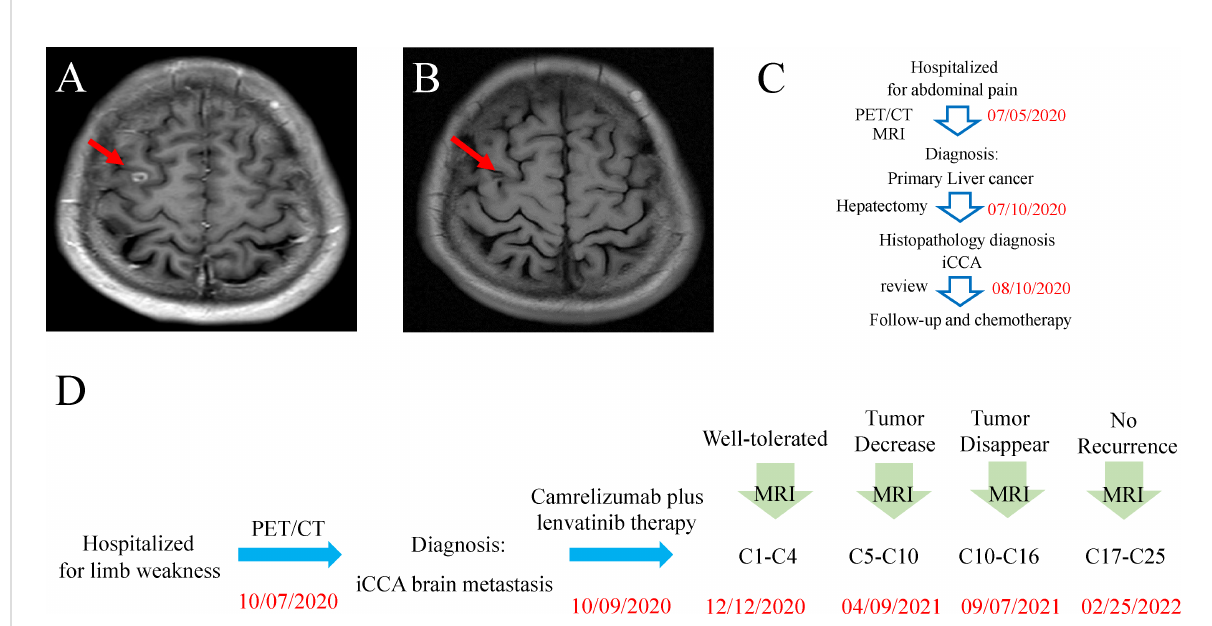
FIGURE 3 (A) Brain MRI scan after treatment with camrelizumab and lenvatinib for 4 cycles. (B) Brain MRI scan after treatment with camrelizumab and lenvatinib for 16 cycles. (C) Timeline of the disease course and treatment before brain metastasis. (D) Timeline of the disease course and treatment after brain